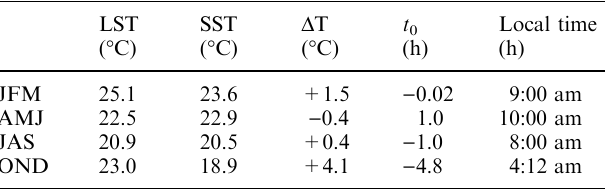
Table 1. Values of LST, SST, (cid:68) T = LST ) SST, t integration), and the local time which corresponds to t month-averages: JFM, AMJ, JAS and OND in the region of Cabo Frio. The SST and LST data are obtained from DHN and INMET, respectively